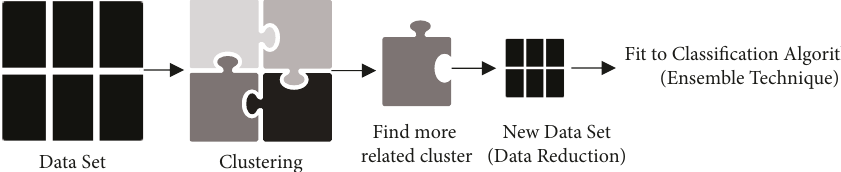
Figure 3: Data reduction from clustering stage to classification